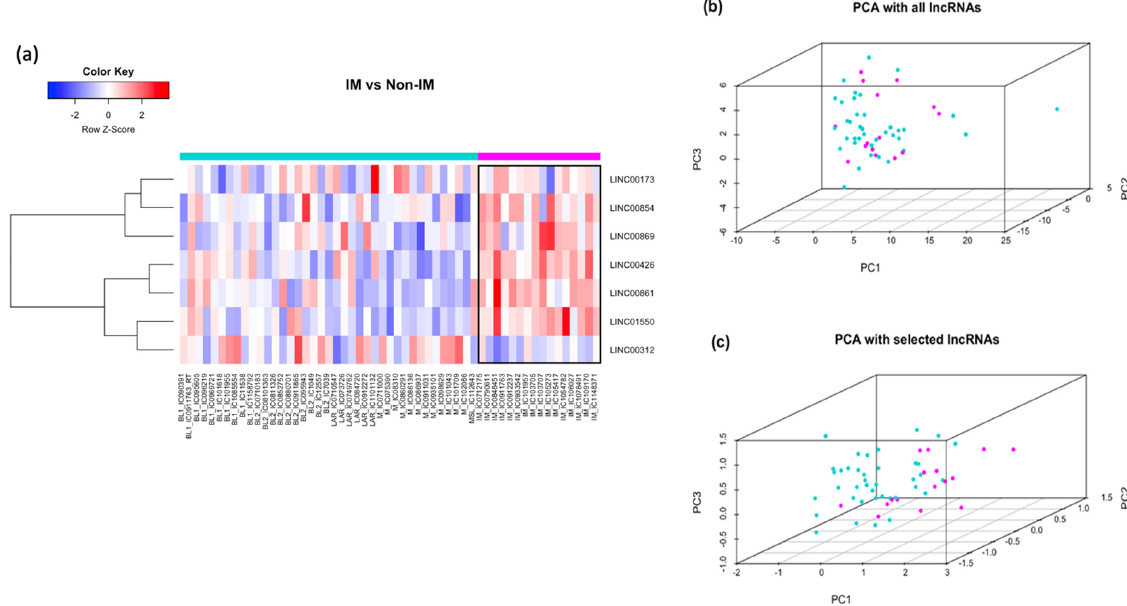
Figure 3. Differential expression of lncRNA between IM vs. non-IM subtypes. ( a ) Heat map from an unsupervised hierarchical clustering of selected lncRNAs based on fold-change ≥ 1.2 and significance level p -value < 0.006. The top bar in magenta shows samples classified as IM; the teal bar represents those classified as non-IM. Red represents up-regulation and blue down-regulation. ( b ) Principal component analysis (PCA) showing a 3D plot of IM (magenta) vs. non-IM (teal) samples when all annotated lncRNAs are used. ( c ) The same plot when using only the seven most significant lncRNAs, which better classifies the IM and non-IM subtypes under analysis. PC: principal components; lncRNA: long non-coding RNA, IM: